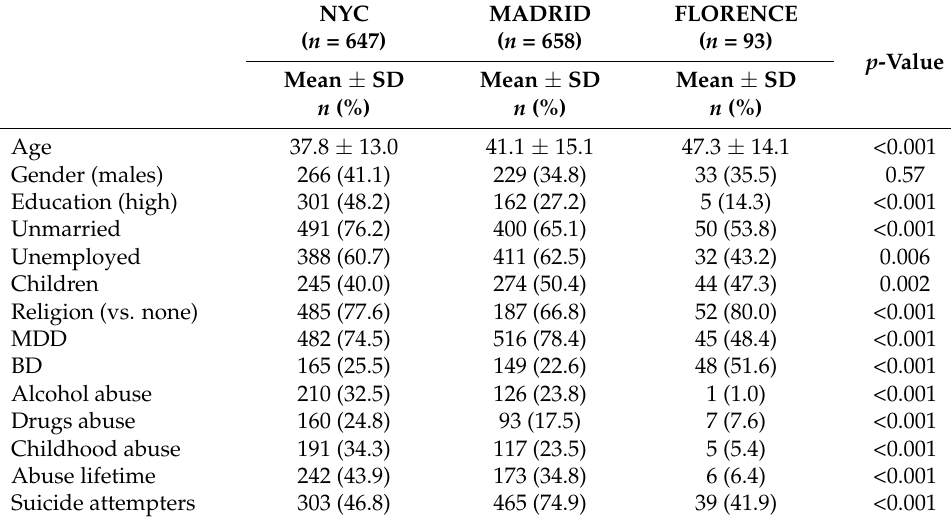
Table 1. Characteristics of the